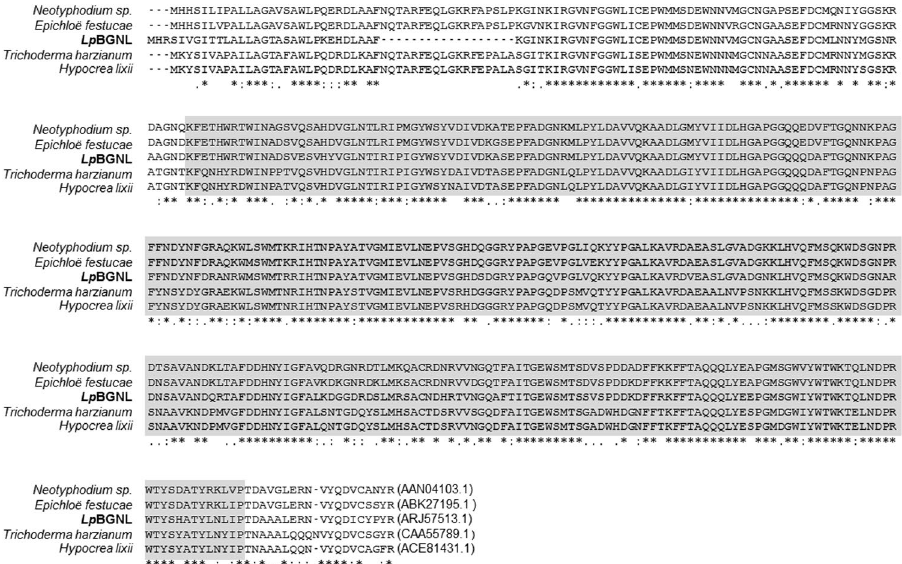
Figure 1. Amino acid sequence alignment of Lp BGNL and fungi ß-1,6-glucanase gene products. The aryl- phospho-beta-D-glucosidase domain is highlighted in grey. Dash ( − ) in the amino acid sequences shows a gap. Following the CLUSTAL W format, asterisk ( * ), colon (:) and dot (.) under the alignment denote ‘conserved amino acid residues’, ‘including conserved substitution(s)’ and ‘including semi-conserved substitution(s)’. NCBI UI is shown at the end of each